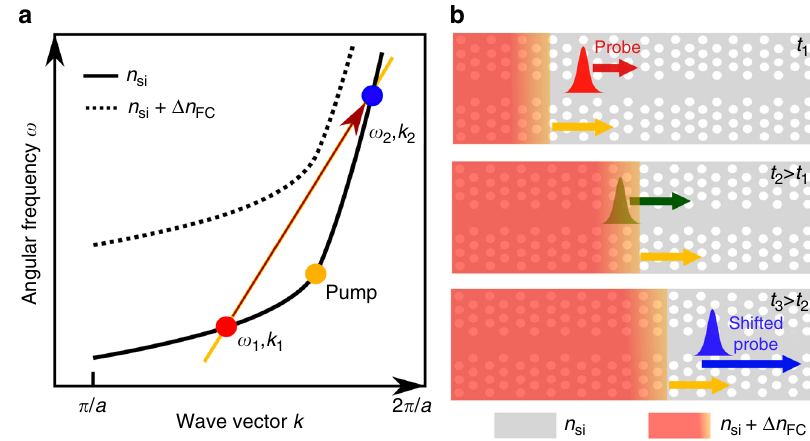
Fig. 1 Schematic of the interaction between front and probe. a Schematic representation of an intraband indirect photonic transition in a slow light silicon PhC waveguide. The solid curve represents the dispersion band of waveguide mode in the ground state (with refractive index n si ), while the dashed curve indicates the switched state with refractive index n si þ Δ n FC . We use the PhC band with positive group velocity to represent the dispersion relationship. The orange line represents the phase continuity line with a slope equal to the group velocity of the pump pulse set at the knee of the dispersion band (orange dot). The red and blue dots indicate the initial (slow mode) and fi nal (fast mode) states of a probe wave, respectively. b Schematic of the experiment. A pump pulse generates FCs in the silicon by TPA and, consequently, induces a change of refractive index which propagates with the velocity of the pump pulse. The region with the red colour gradient corresponds to the rising edge of the front. The orange arrow indicates the velocity of the pump pulse, while red, green and blue arrows indicate the velocities of a wave packet of the probe at different times,